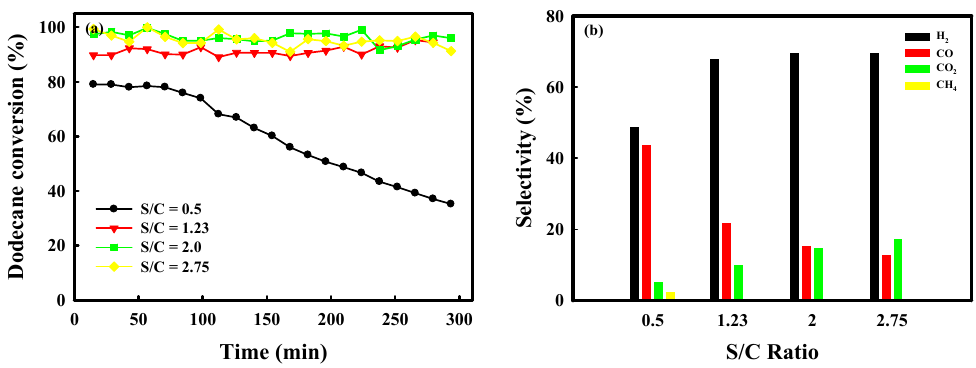
Figure 6. Effect of S/C ratio on catalytic performance: ( a ) Dodecane conversion and ( b ) initial selectivity of auto-reduced NA10-PM catalyst under O 2 /C = 0.25, and GHSV = 12,000 h − 1 at 750 °C.